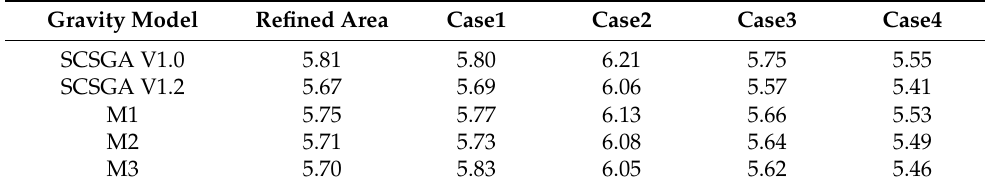
Table 10. RMS of differences between gravity models and the testing shipborne data (in mGal).